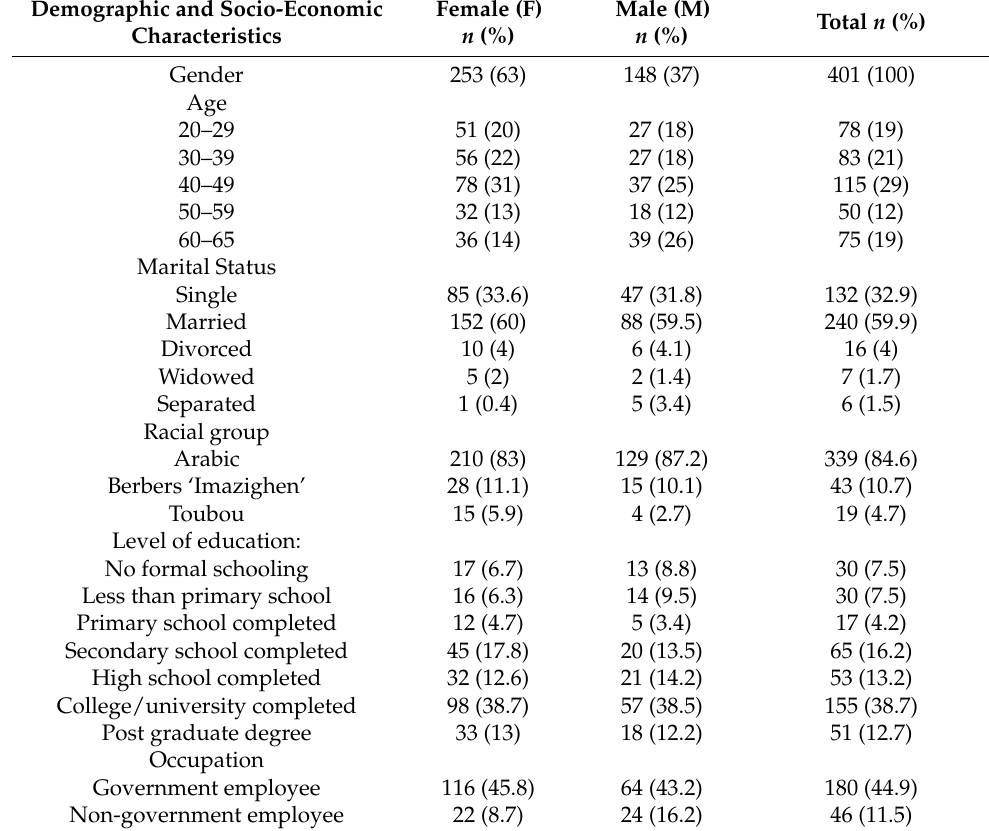
Table 2. Demographic and anthropometric measurement characteristics of the participants ( n =